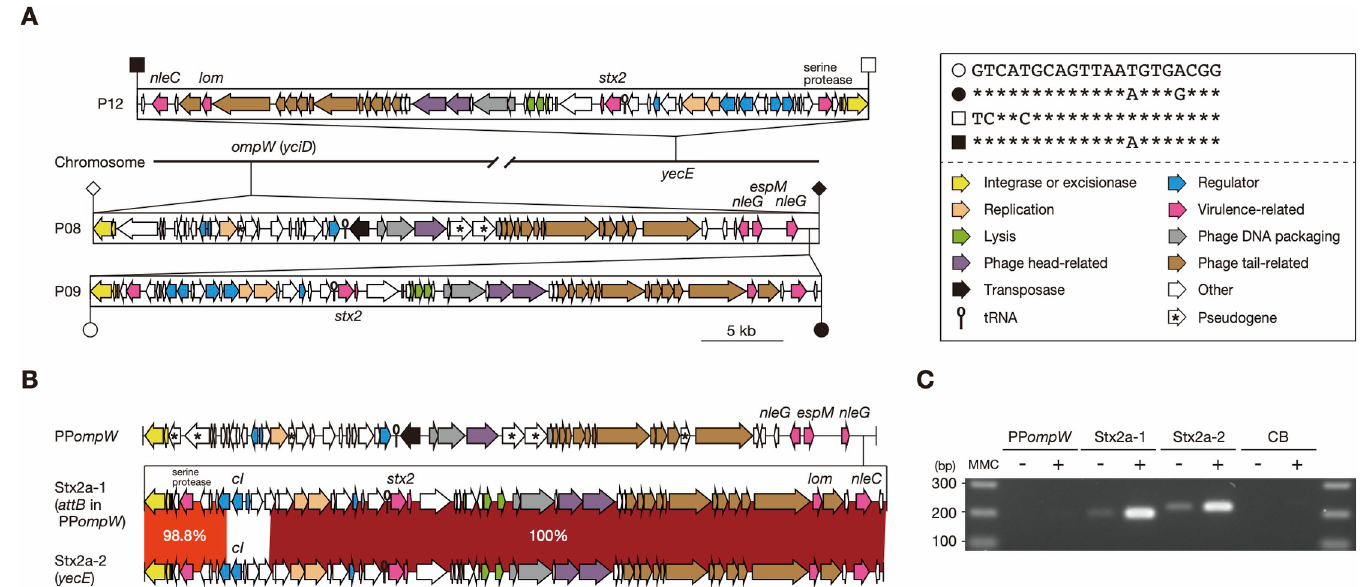
Fig 1. Integration sites of the inducible and packageable duplicated Stx2a phages in two STEC O145:H28 strains. (A) The duplicated Stx2a phages and their att sequences in strain 112648. The genome structures of three prophages (P08, P09, and P12) are drawn to scale. The att sites of each prophage are indicated by open ( attL ) or filled ( attR ) symbols (P08, rhombus; P09, circle; P12, square). The att sequences of the Stx2a phages (P09 and P12) are shown in the inset. (B) The genome structures of two Stx2a phages and a lambda-like phage integrated into ompW (PP ompW ) in strain 12E129. Sequence homology between the two Stx2a phages is also shown, with their integration sites indicated in parentheses. Homologous regions are indicated by shading with different colors according to sequence identity. The integrase gene of PP ompW and the cI gene on each Stx2a phage were targeted by the PCR primers used in Fig 1C. (C) Detection of packaged DNA of the three prophages in the DNase- treated lysates of strain 12E129 with (+) or without (-) MMC treatment. The chromosome backbone (CB) region was amplified as a negative